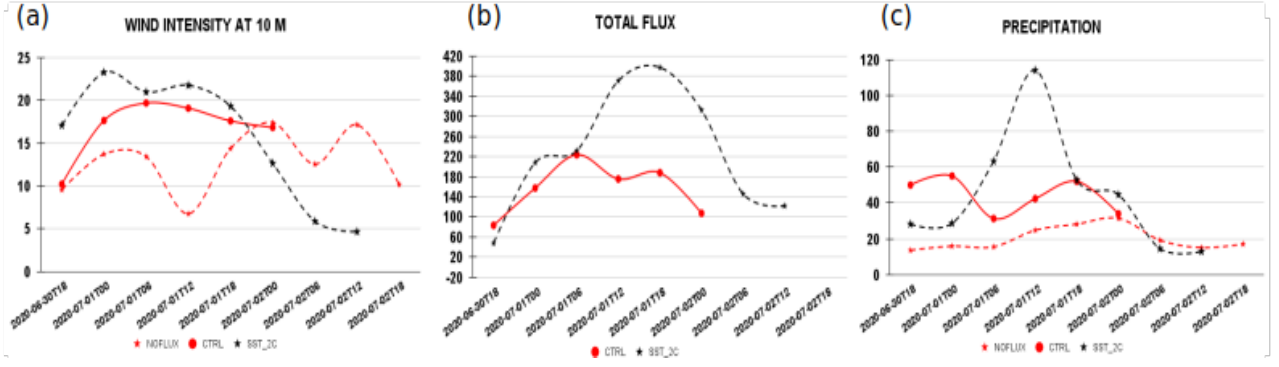
Figure 10. Time evolution of ( a ) 10 m wind intensity (m s −1 ), ( b ) total heat fluxes (W m −2 ), and ( c ) accumulated precipitation (mm 6 h −1 ) in the experiments ERA_BMJ (solid red line), ERA_BMJ_NO (dashed red line), and SST_2C (dashed black line). All variables were computed in a box of 10° × 10° with cyclone in its center.